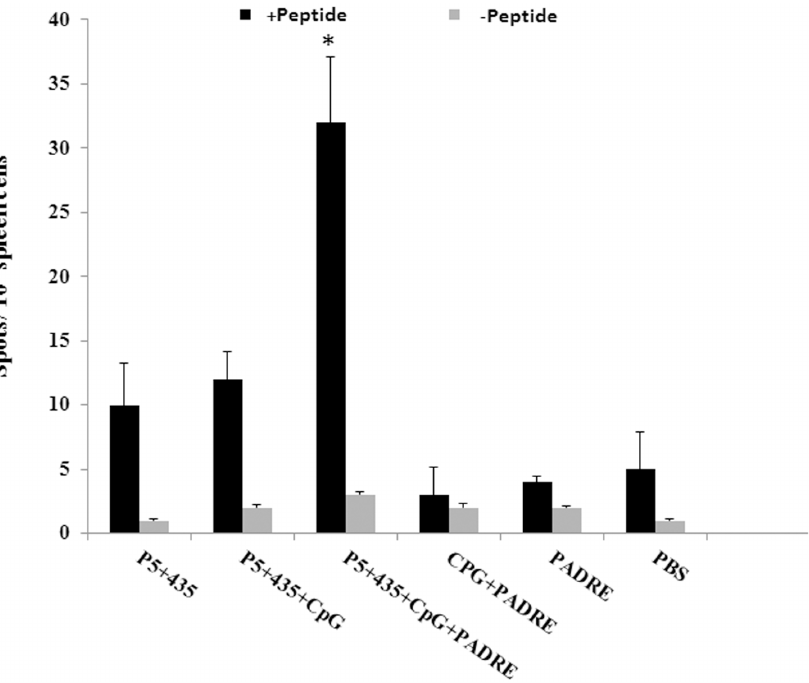
Fig 1. Evaluation of the amount of IFN- γ produced in vaccinated mice. Nine BALB/c female mice per group were vaccinated three times subcutaneously with 100 μ g/mouse of P 5+435 long peptide, P 5+435 in combination with CpG, or in combination with both 50 μ g/mouse of PADRE and 25 μ g/mouse of CpG. Two weeks after the last vaccination, splenocytes from three mice from each group were collected and activated with the long peptide. Immune responses were then determined using an IFN- γ ELISpot assay. The data indicate the mean ± SD. (n = 3). * denotes significant difference from all other groups (P <